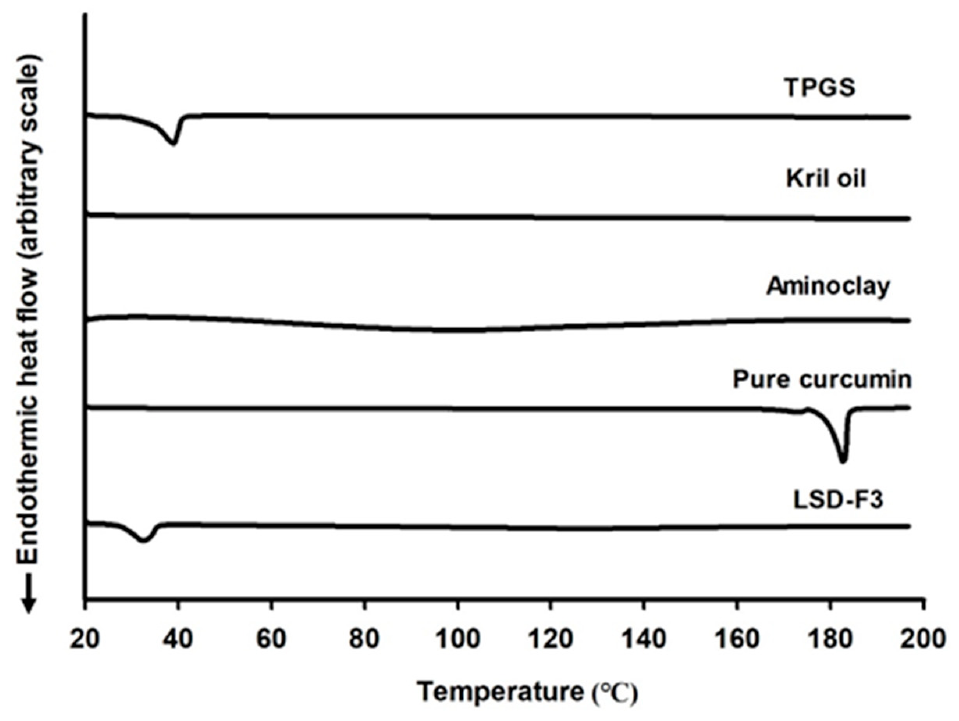
Figure 2. DSC curves of pure curcumin, LSD-F3, and formulation components.